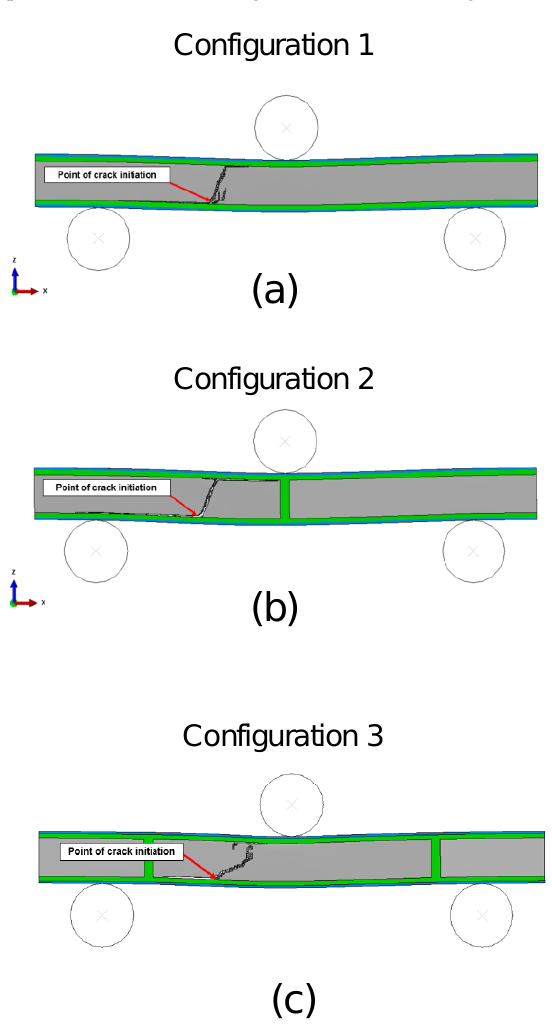
Figure 10. Comparison between experimental and numerical load–displacement curves for the specimens with ( a ) ‘Configuration 1’, ( b ) ‘Configuration 2’ and ( c ) ‘Configuration 3’.